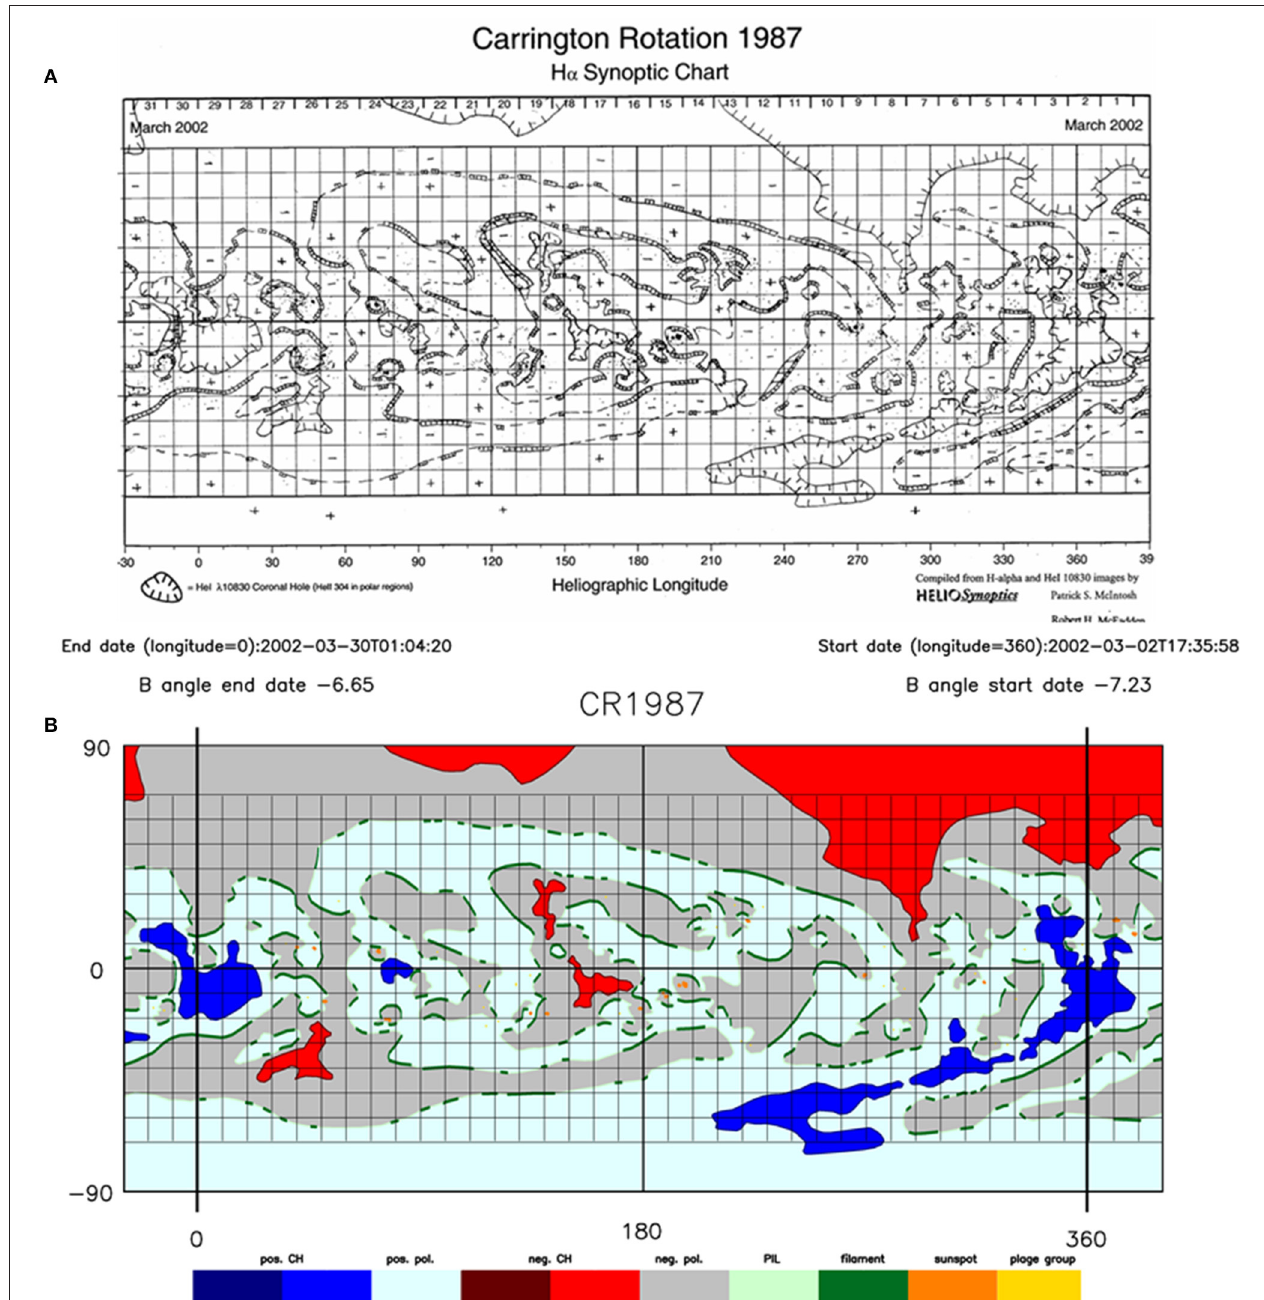
FIGURE 1 | (A) Scanned image (Level 0) of an original synoptic map in from March 2002 created by Pat McIntosh. (B) Processed colorized map (Level 3) from the new McIntosh archive with negative (gray) and positive (white) polarity magnetic fields, negative (red) and positive (blue) CHs, filaments (green), and PILs (black). The Supplementary Material contains movies of the full McA of the original synoptic maps (Level 1; Movie 1 ) and of the final processed maps (Level3; Movie 2 ).